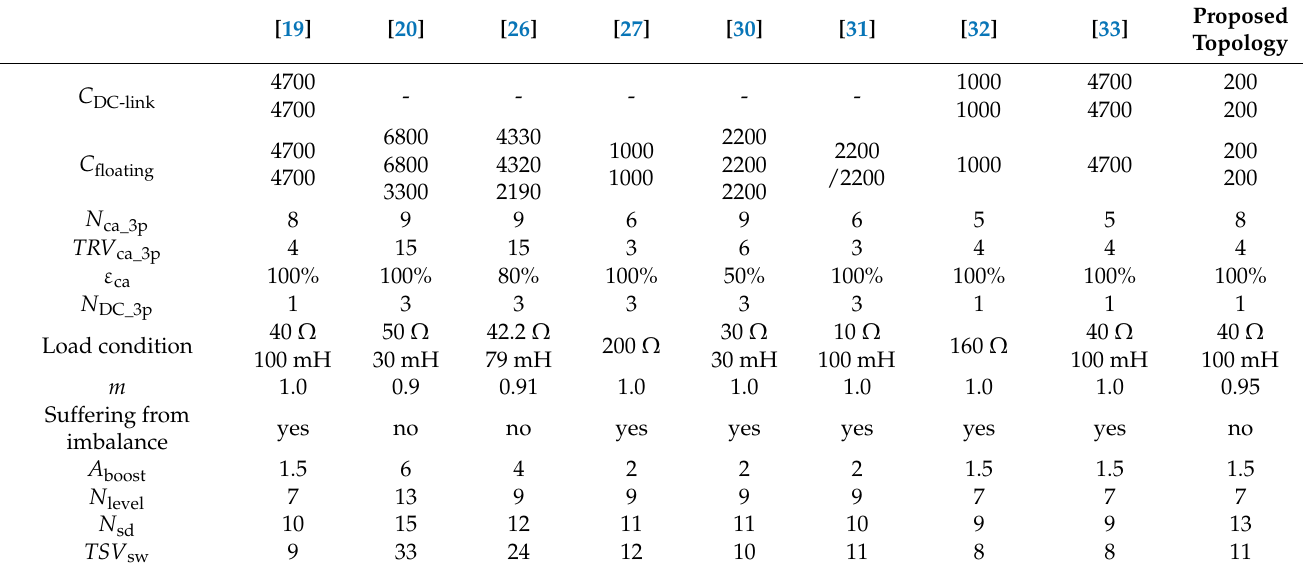
Table 4. Comparison of different topology